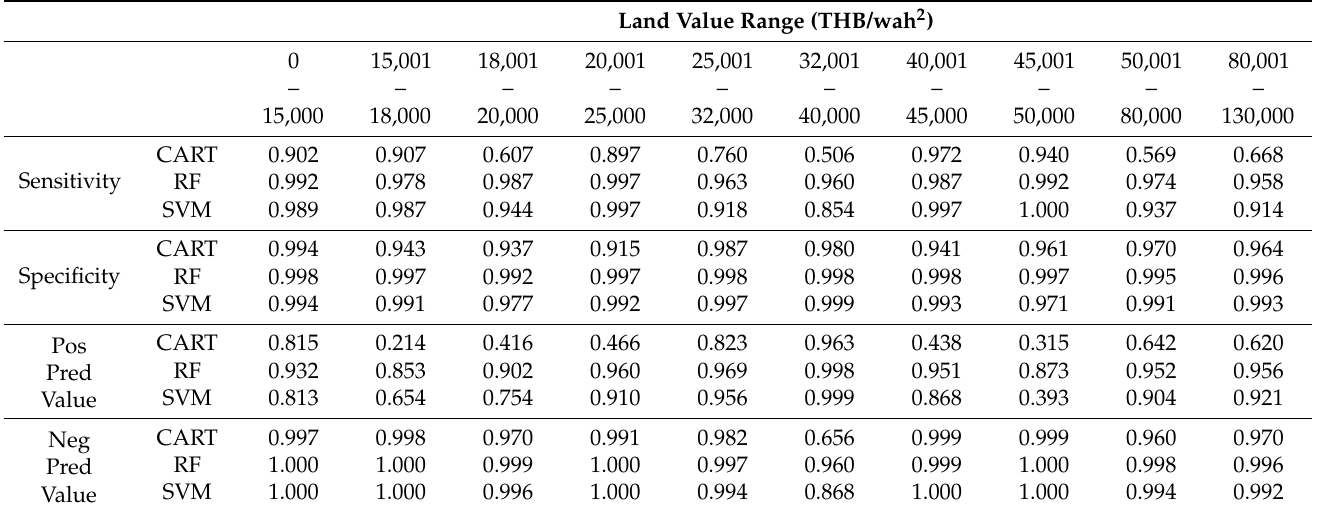
Table 8. Model development in the testing area.